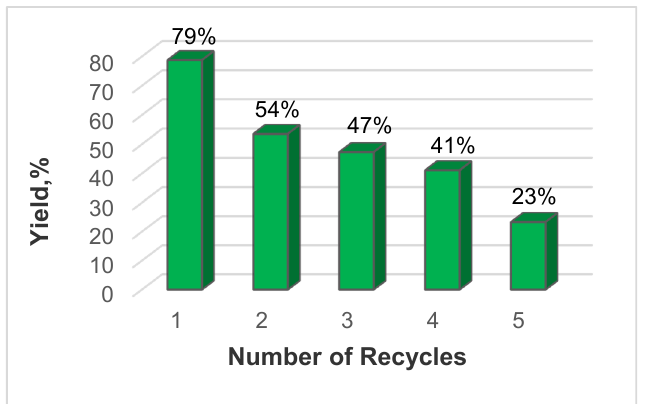
Figure 5. Effect of Au/TiO 2 recycling on the yield of 1,2,3-triazole product. Reaction conditions: 1.0 mol% of Au/TiO 2 vs. benzyl bromide, 15 min, MW (30 W, 150 °C).